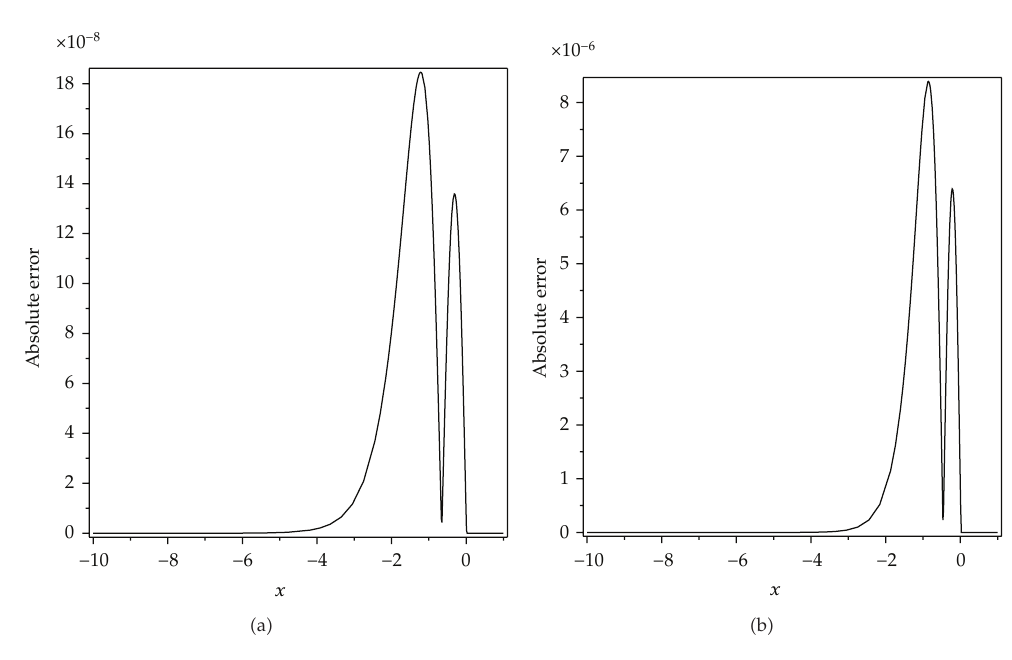
Figure 5: The absolute error of HPM at t (cid:9) 0 . 01 (cid:3) a (cid:4) c (cid:9) 1 (cid:3) b (cid:4) c (cid:9)